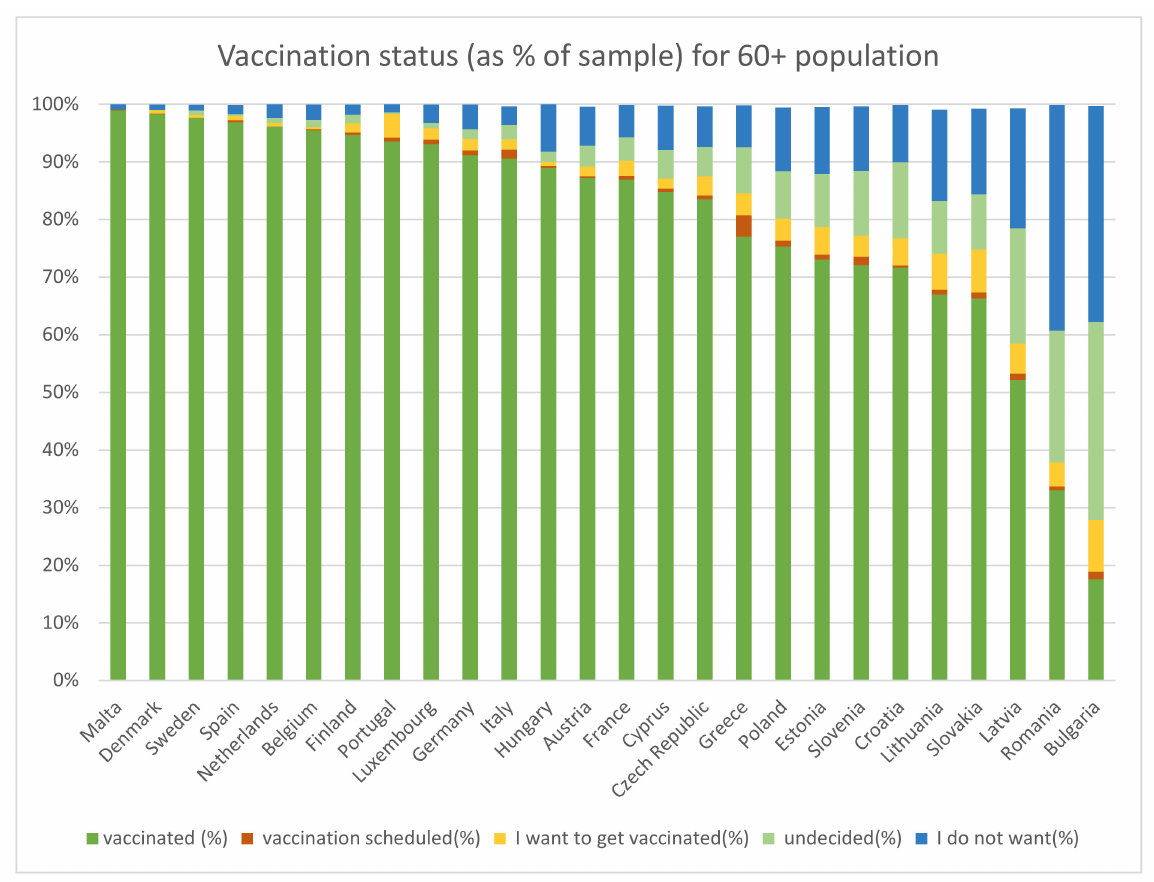
Figure 1. SHARE COVID-19 survey vaccination status for the 60+